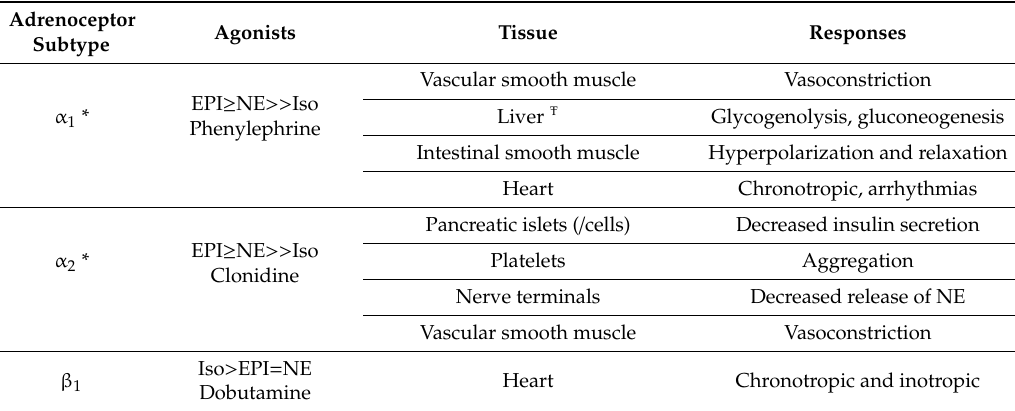
Table 1. Characteristics of subtypes of adrenergic receptors.